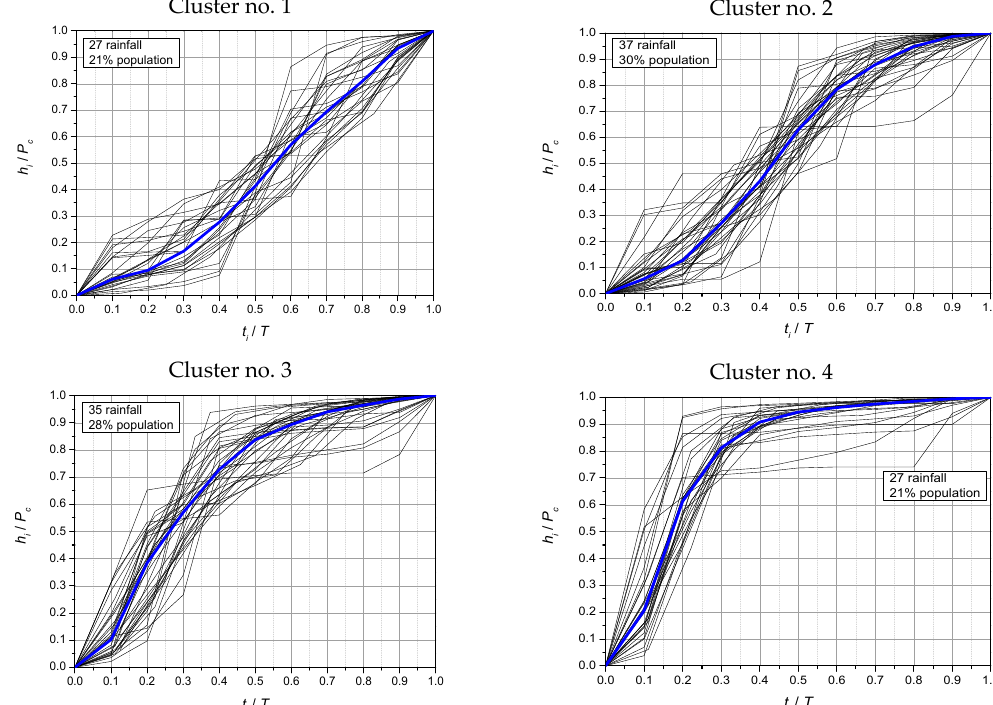
Figure 3. Mass rainfall curves with the median in four clusters separated by k -means method for Wrocław.